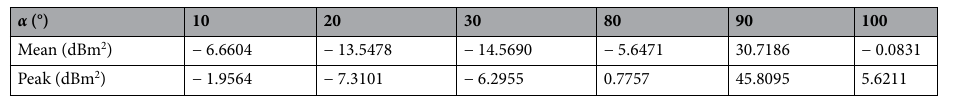
Table 5. RCS indicator of the aircraft, β = 0°, f RH = 6 GHz, ω m1 = ω m2 = 0.1963 rad/s, t = 0 ~ 4.407